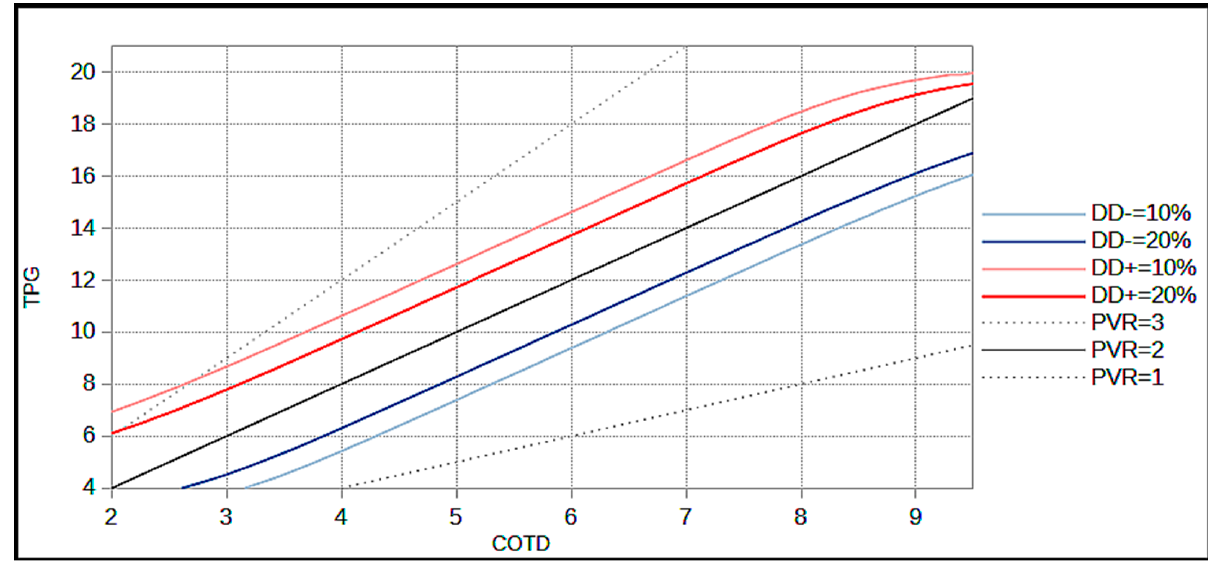
Figure 4. IsoDgDis and isoPVR graph. The same graph as above is shown with the addition of isoPVR line at 1 WU and 3 WU. This highlights the impact of CO and PVR values on diagnosis disagreement. COTD: Cardiac Output using Thermodilution; DgDis (DD): diagnosis disagreement (DgDis (DD)+) corresponds to false positive diagnosis using TD; DgDis (DD) − corresponds to false negative diagnosis using TD); PVR: pulmonary vascular resistance; TPG: transpulmonary gradient.